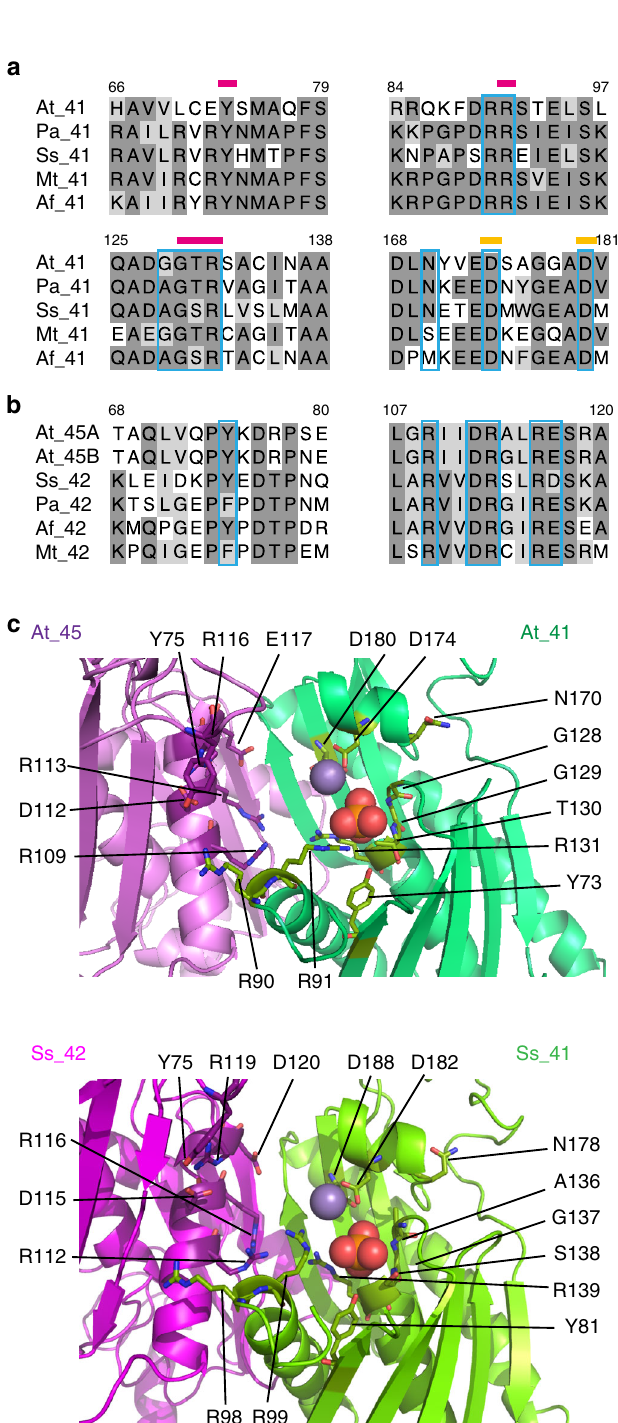
Fig. 1 Amino acids crucial for the phosphorolytic activity of archaeal exosomes are conserved in Arabidopsis RRP41-RRP45 subunits. The Arabidopsis RRP41, RRP45A, and RRP45B sequences were aligned to their respective RRP41 and RRP42 counterparts from four archaeal species for which exosome structure is known: Ss, Sulfolobus solfataricus; Pa, Pyrococcus abyssi; Af, Archaeoglobus fulgidus; Mt, Methanothermobacter thermautotrophicus . Amino acid numbering refers to the Arabidopsis sequences. Amino acids involved in RNA binding are boxed in blue, amino acids involved in Pi and Mg 2+ coordination are marked with magenta and yellow bars, respectively. a Partial alignments of Arabidopsis and four involved in RNA binding, Pi and Mg 2+